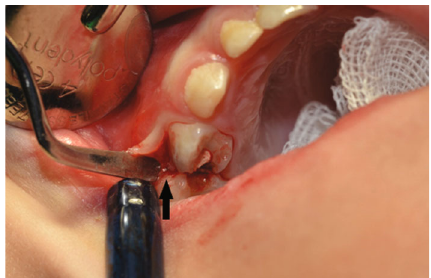
Figure 3: The broken needle is visible (black arrow) in periodontal ligament space of tooth 55 after fl ap re fl ection.